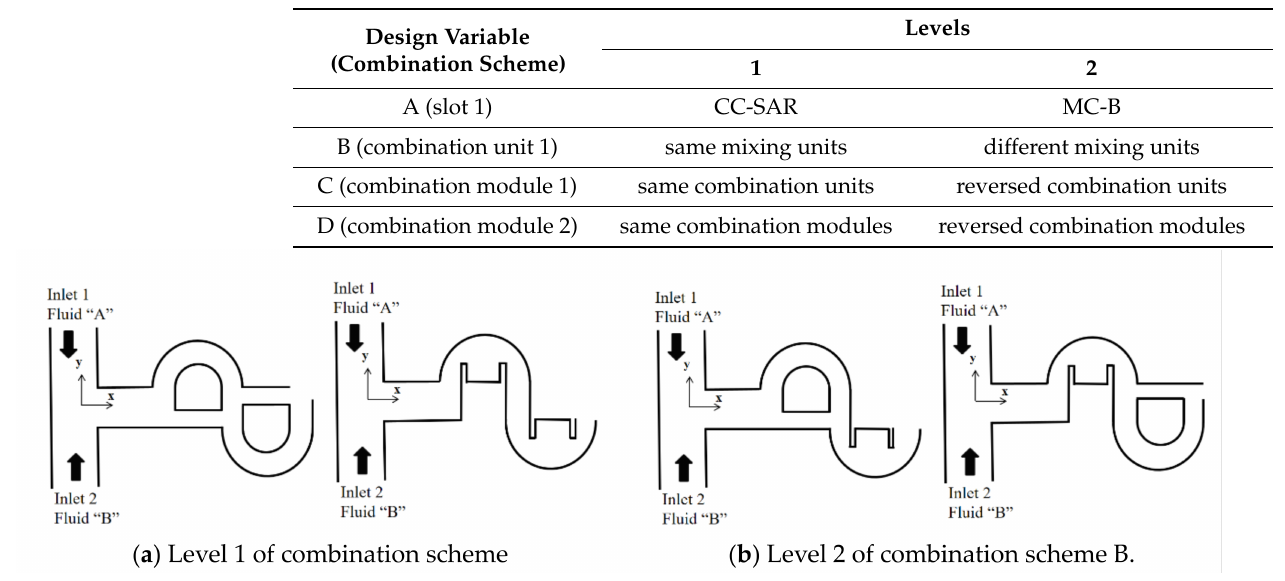
Figure 3. Four possible layouts of the first combination unit (nonproportional).